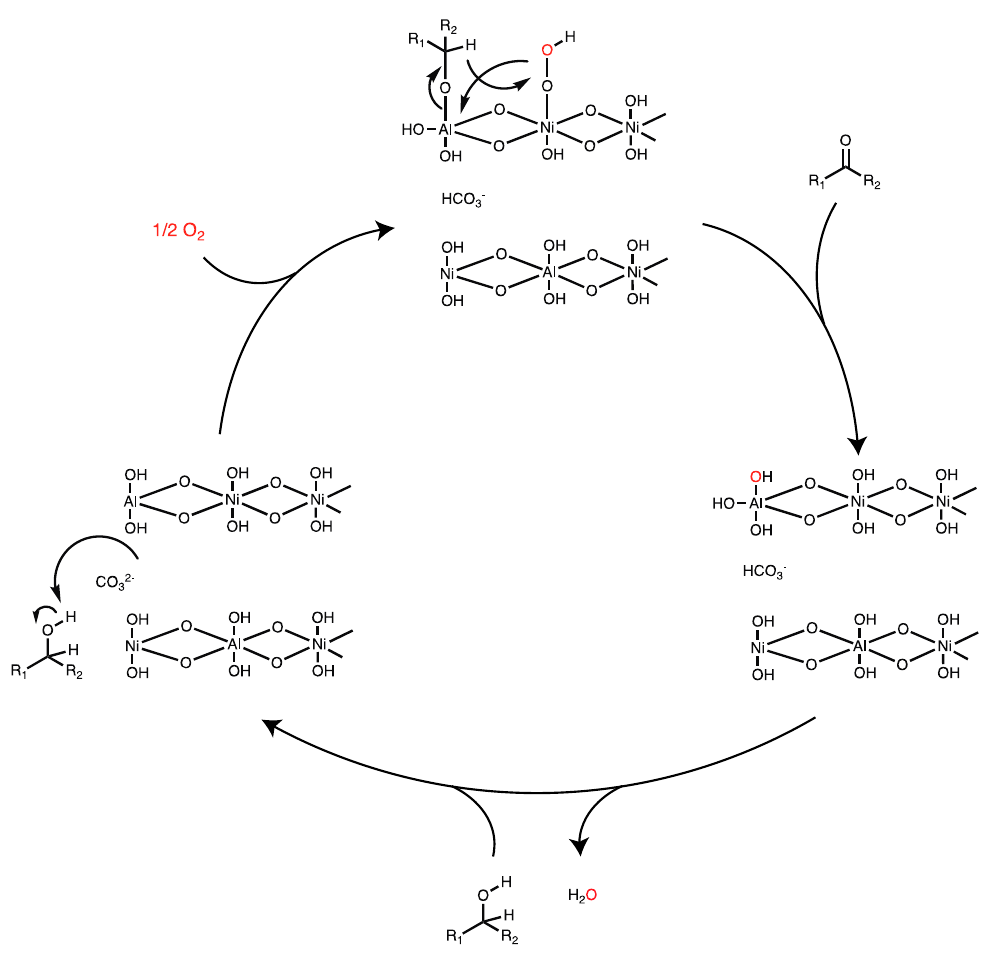
Figure 2. Plausible mechanism for LDH ‐ catalyzed aerobic alcohol oxidation.